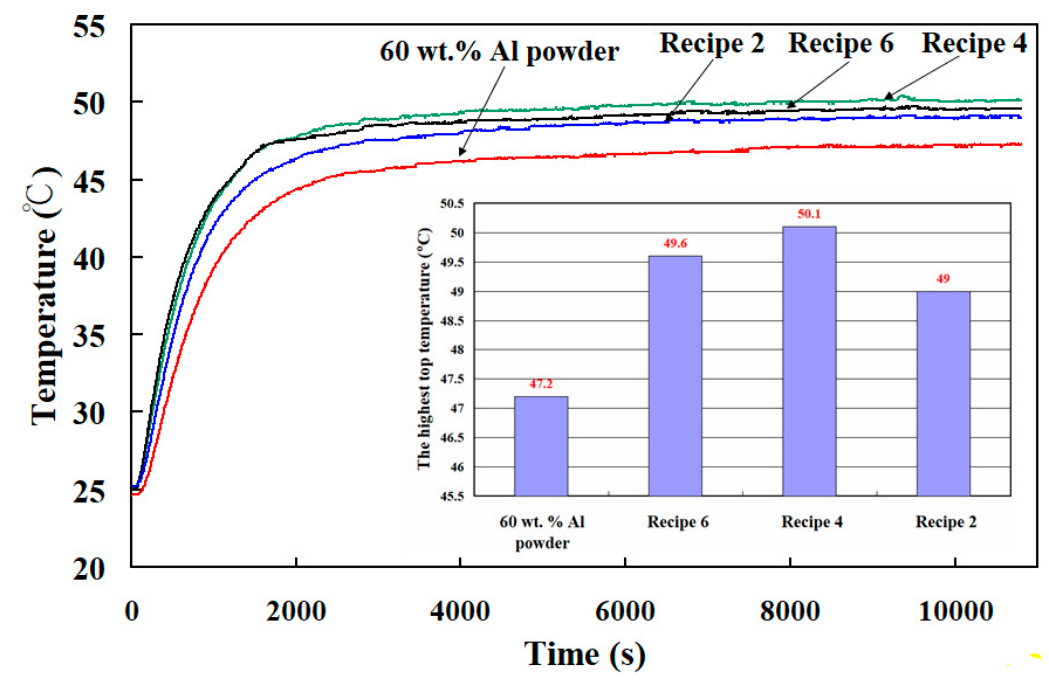
Figure 10. The top temperature of the specimens as a function of time.